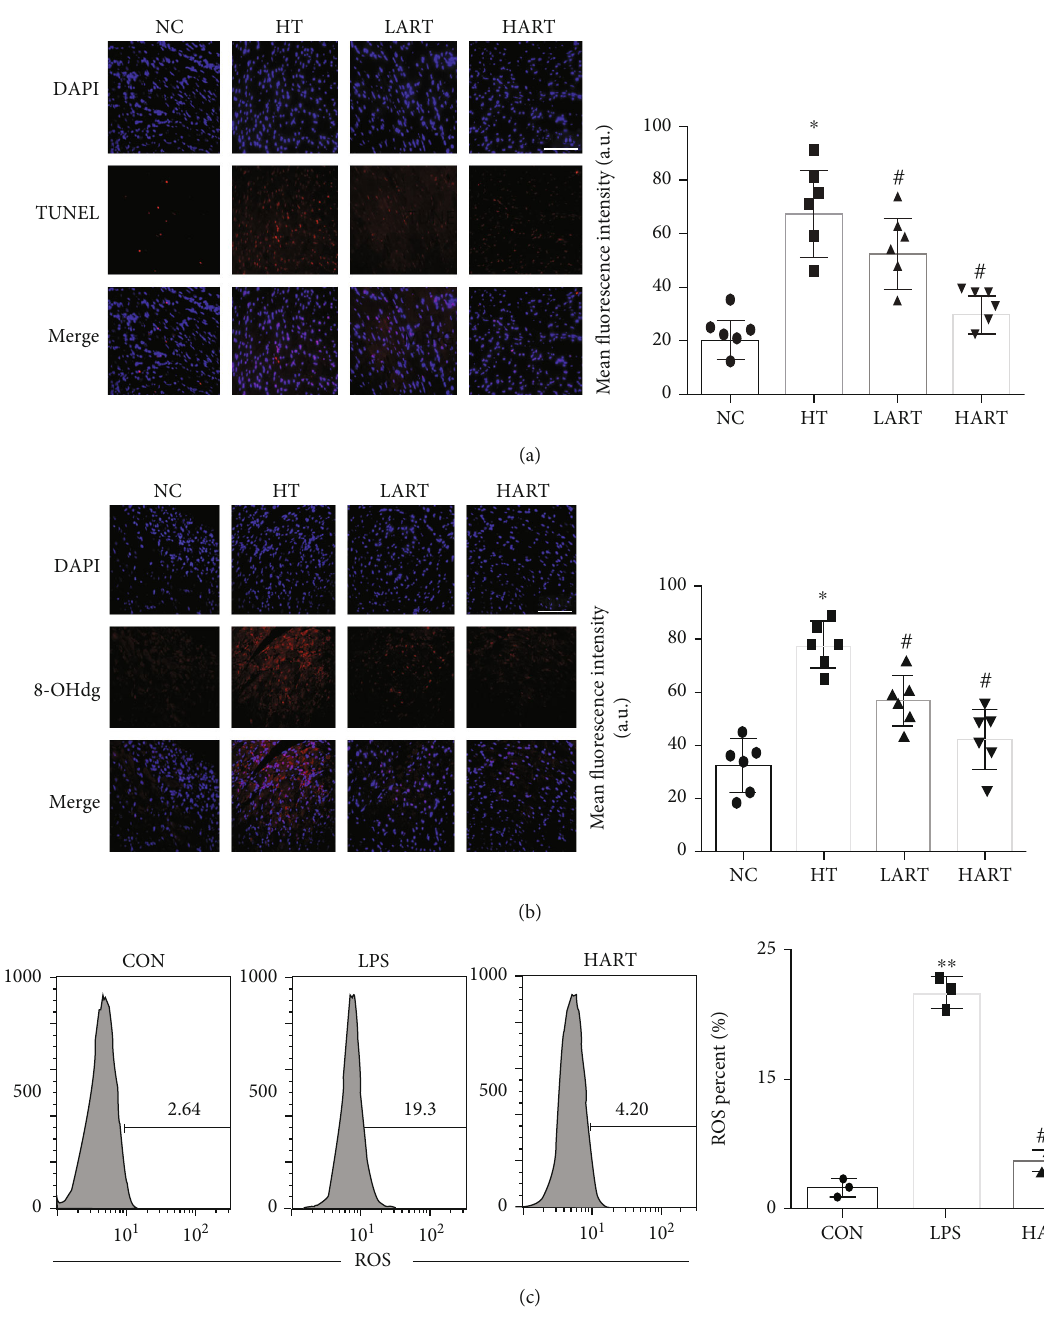
Figure 4: (a) TUNEL staining and mean fl uorescence intensity of the heart (blue: DAPI, red: TUNEL); (b) 8-OHdg staining mean fl uorescence intensity of the heart (blue: DAPI, red: 8-OHdg; ∗ P < 0 : 05 compared with NC; # P < 0 : 05 compared with HT); (c) ROS of DCs after stimulation with LPS ( ∗∗ P < 0 : 01 compared with CON; ## P < 0 : 01 compared with